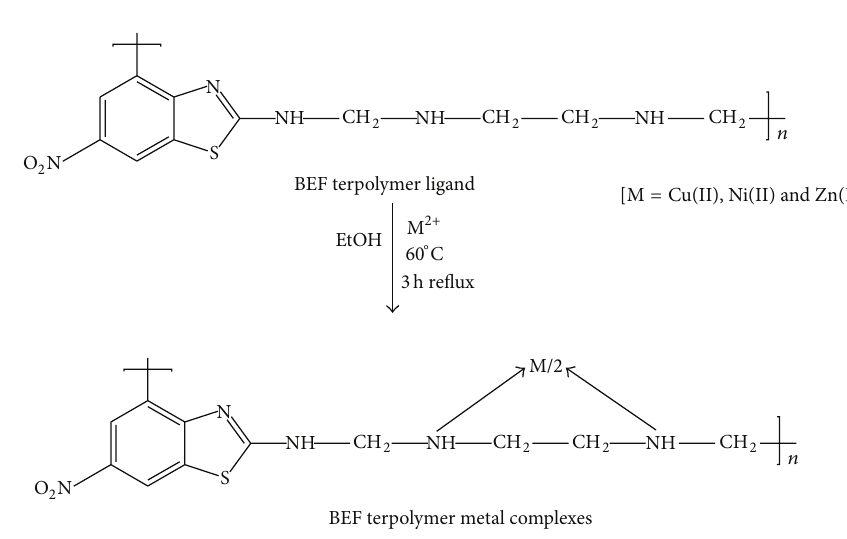
Scheme 1: Reaction route of the BEF terpolymer ligand.